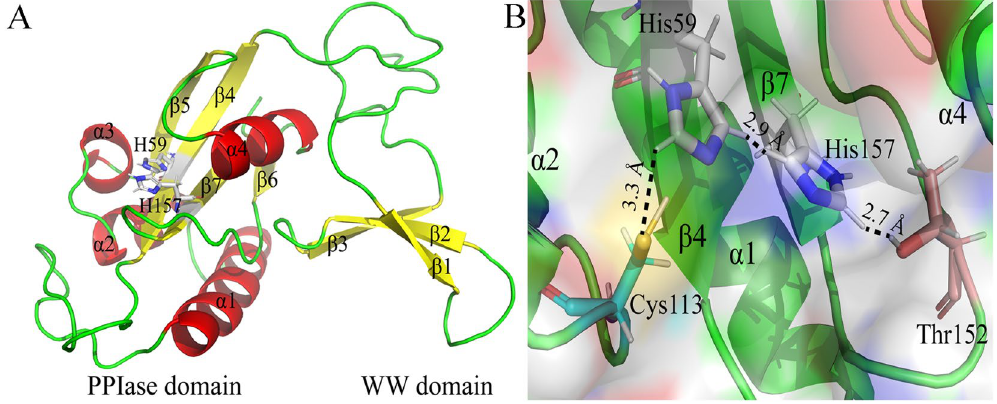
Figure 1. The three-dimensional structure of Pin1. ( A ) The Overall crystal structure of Pin1. Yellow arrows, green lines and red helixes represent β -sheet, random coil and α -helix, respectively. The model of white sticks represents residues His59 and His157, respectively. ( B ) The dual-histidine motif of Pin1. The model of white, blue-green and pink sticks represents histidine, cysteine and threonine residues, respectively. The black line represents hydrogen